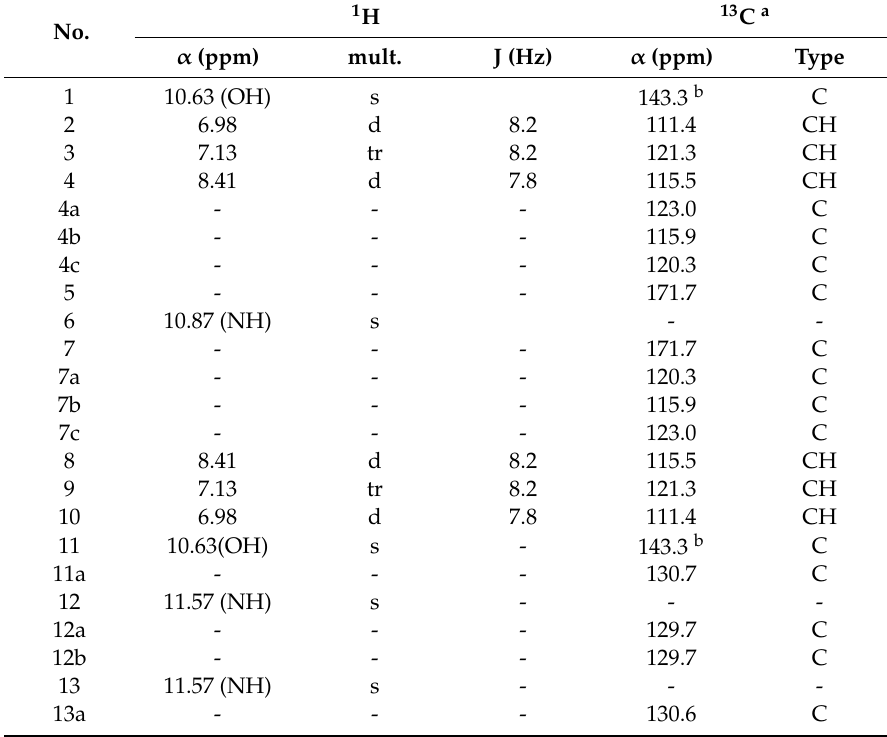
Table 1. 1 H and 13 C-NMR of BE-13793C 1 at 600 MHz and 298